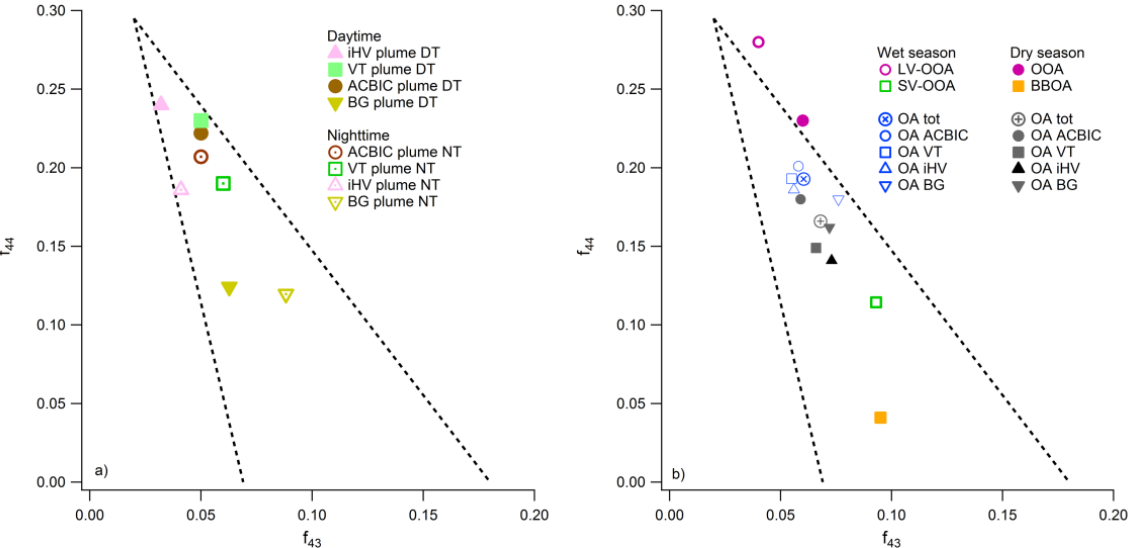
Fig. 10. Triangle plots (a) for day and nighttime source region plumes and (b) for source region averages and for indentified organic groups, i.e., LV-OOA, SV-OOA, OOA and BBOA. The dotted lines define the triangular space where ambient OA components usually fall. Triangle plot is described detail in Ng et al. 2010.